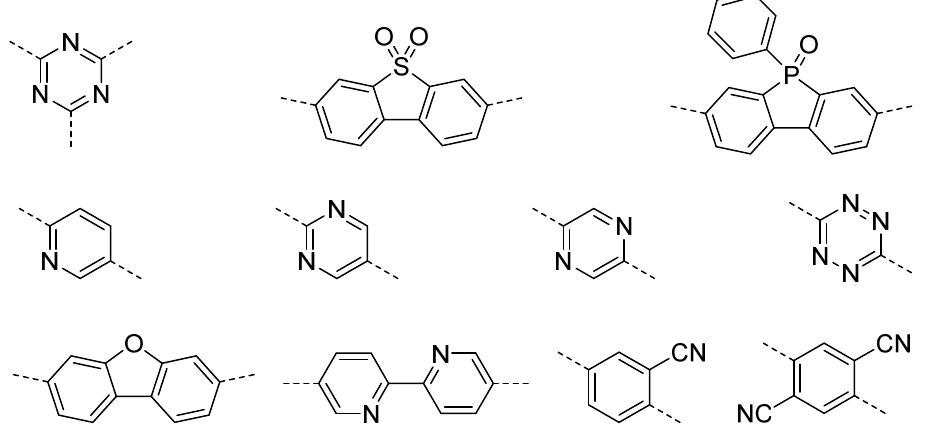
Figure 7. Examples of polar building blocks used to change the polarity of the backbone of polymer photocatalysts [19,32,60,62–65].